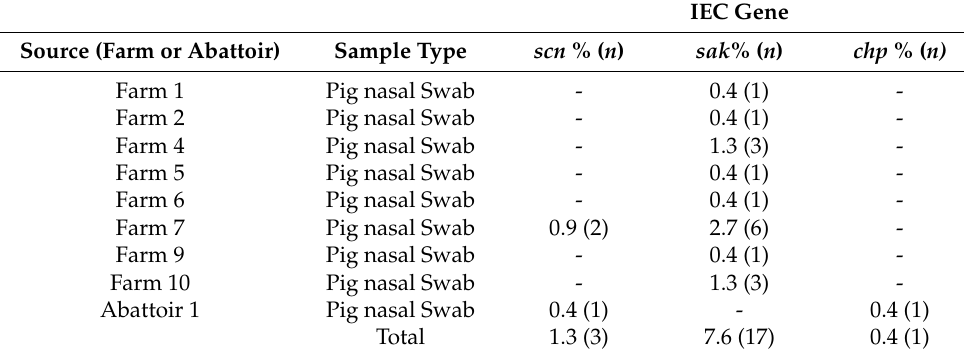
Table 4. IEC genes distribution among the S. aureus isolates ( n = 225).